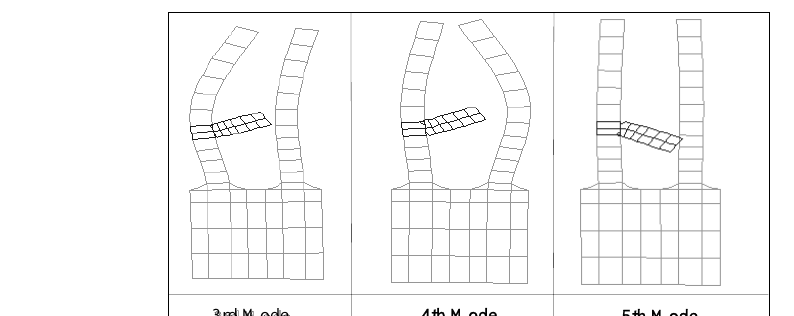
Fig. 8. Frequency response of the turbine blade.